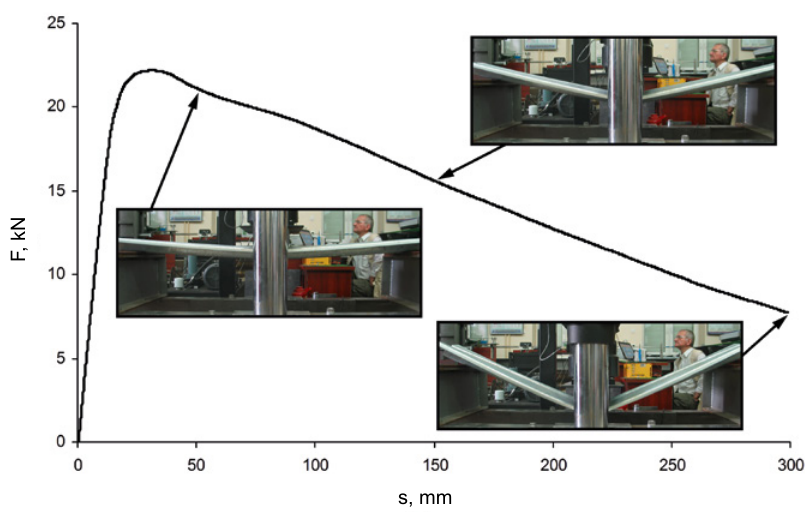
s, Figure 4. F(s) chart obtained in three-point bend test of validation segment